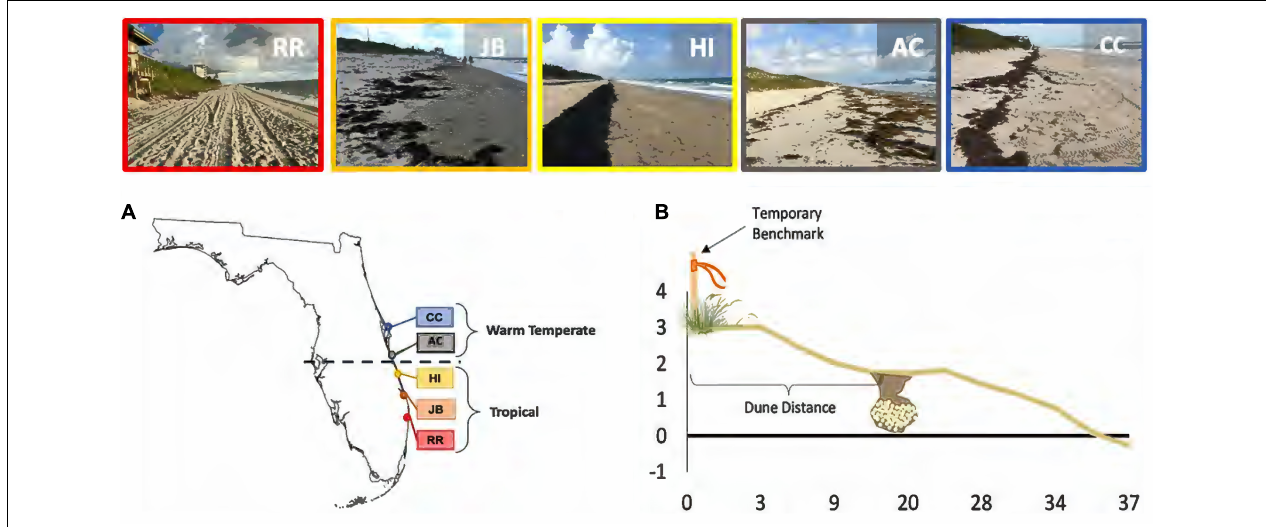
FIGURE 1 | Site map with nesting habitat illustrated for each beach. (A) Study beaches by location relative to the bioclimatic break shown by dashed line. (B) Diagram profiling a nesting beach with a clutch located at the middle beach. The temporary benchmark was used to establish beach morphology transects. Red Reef Park, Boca Raton (RR), Juno Beach (JB), Hutchinson Island (HI), Archie Carr National Wildlife Refuge (AC), and Canaveral National Seashore (CC).